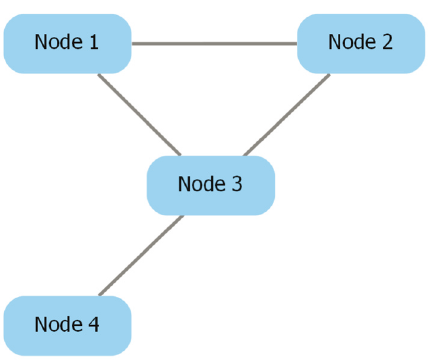
Figure 4. The network exported with the “Straight segments” option, as “splines = ‘false’” in the output Graphviz file.